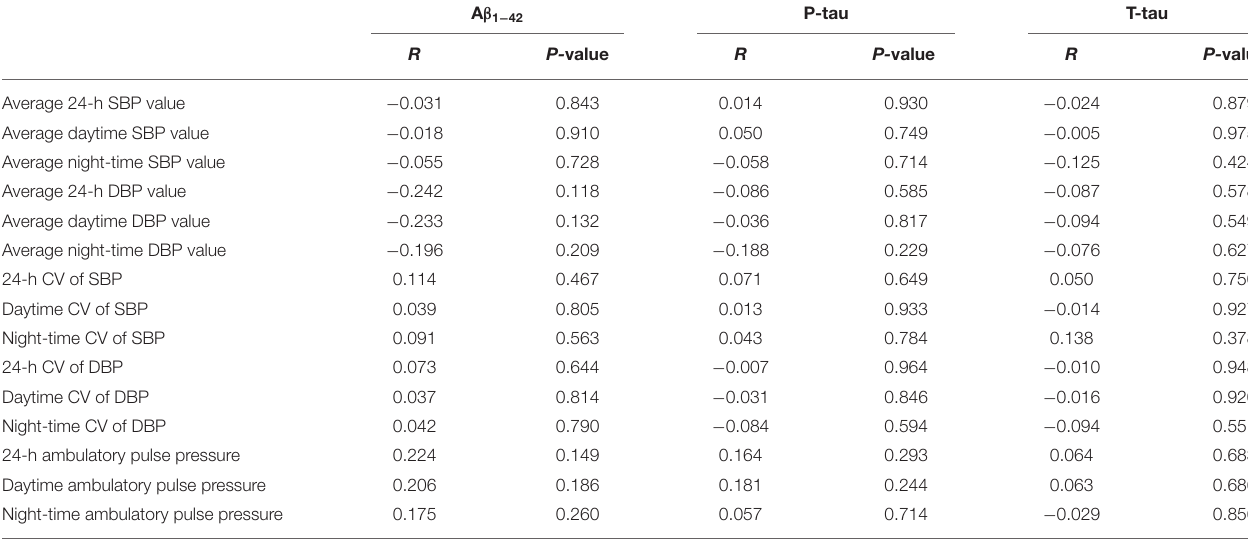
TABLE 6 | Correlations between neuropathological biomarkers of AD and 24-h ambulatory BP variables in patients with